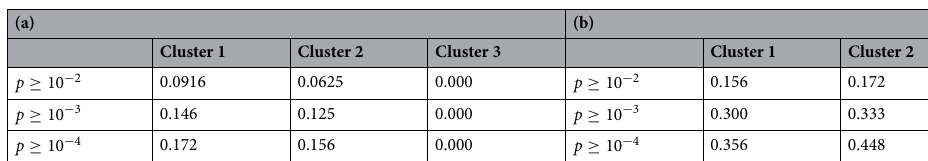
Table 2. Rates of trends within clusters, which are generated from the unimodal Gaussian distribution. We investigated whether the p values of the Shapiro–Wilk test for the trends are greater than the thresholds. (a) Results for IPCA. (b) Results for